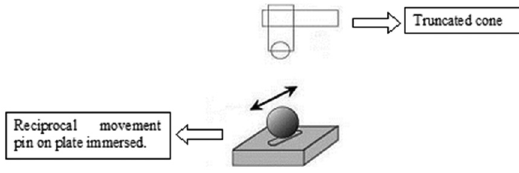
Figure 3. Schematic representation of the tribologic test system.